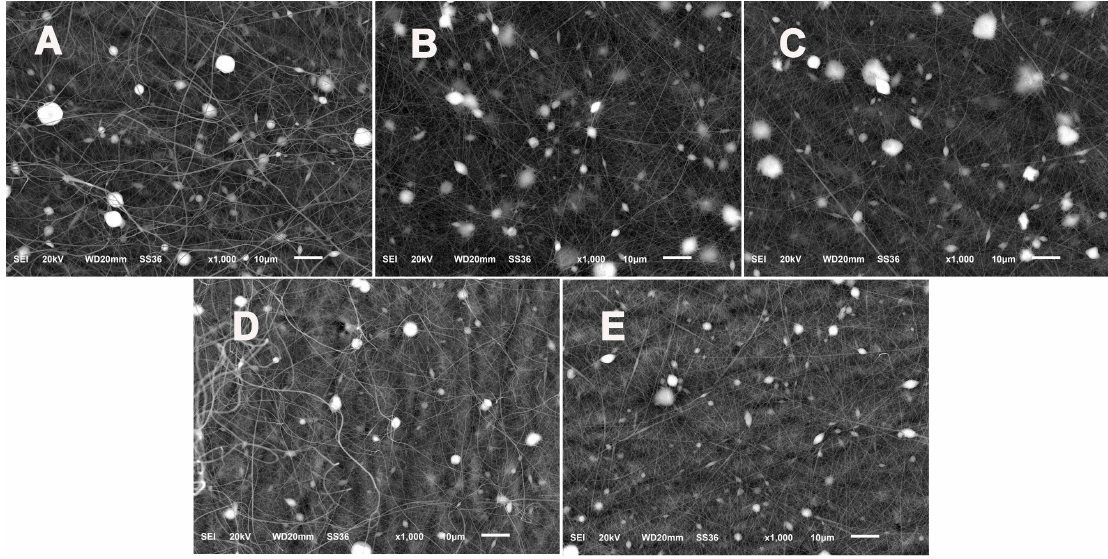
Figure 8. SEM images of cSG-PAN prepared with different vertical distance between the buret tip and collector: ( A ) 12.5; ( B ) 14.5; ( C ) 16.5; ( D ) 18.5; ( E ) 20.5 cm.